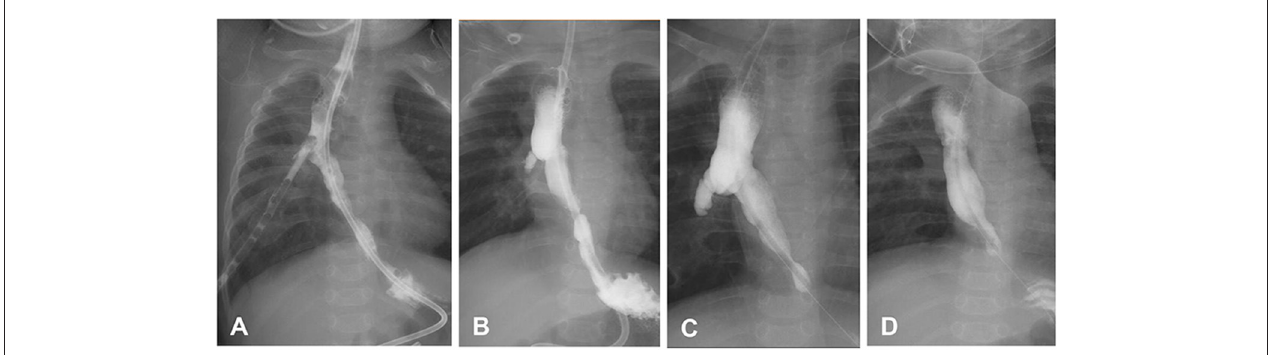
FIGURE 2 | Changes in the esophageal diverticulum (ED) of patient 3. (A) After esophageal atresia/tracheoesophageal fistula surgery, the contrast agent flowed into the chest drainage tube through the esophageal anastomosis leakage. (B) The thoracoscopic drainage tube was removed prematurely, and the ED appeared. (C) The ED was enlarged. (D) Two weeks after diverticulectomy, the esophagus was in good shape. In C and D, the patient underwent laparoscopic fundoplication, leading to postoperative distal esophageal stenosis.